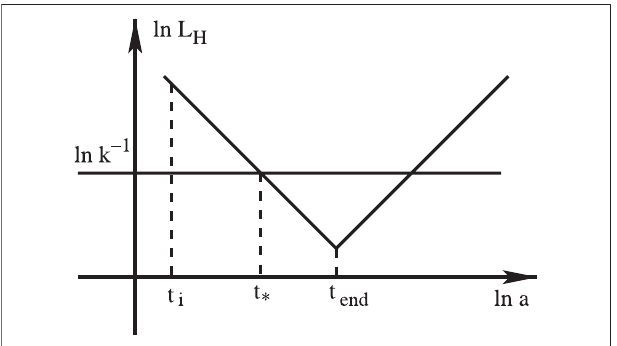
FIGURE2| TheevolutionofthecomovingHubbleradiusln ( L H ) vs.ln ( a ) inGR,where t i denotesthemomentoftheonsetoftheslow-rollin fl ation, t p